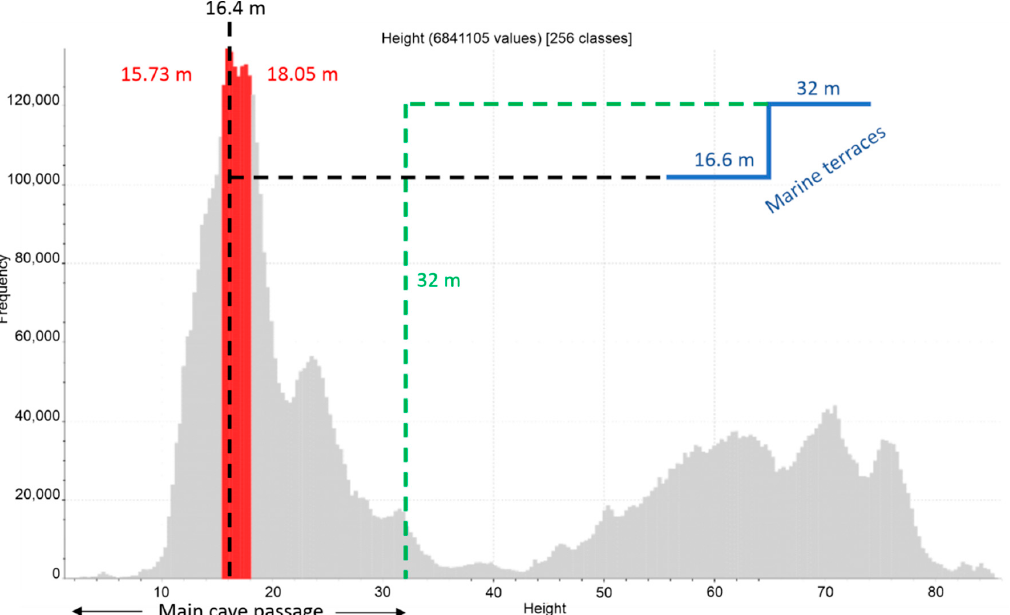
Figure 6. Histogram of the height frequency of Selinitsa Cave, extracted by 3D scanning. The horizontal axis corresponds to the height, and the vertical axis corresponds to frequency. The red range depicts the largest space in the cave. The black dotted line shows the peak of the latter space, whereas the green dotted line delimits the height of 32 m. Both heights are correlated with the marine terraces of the studied